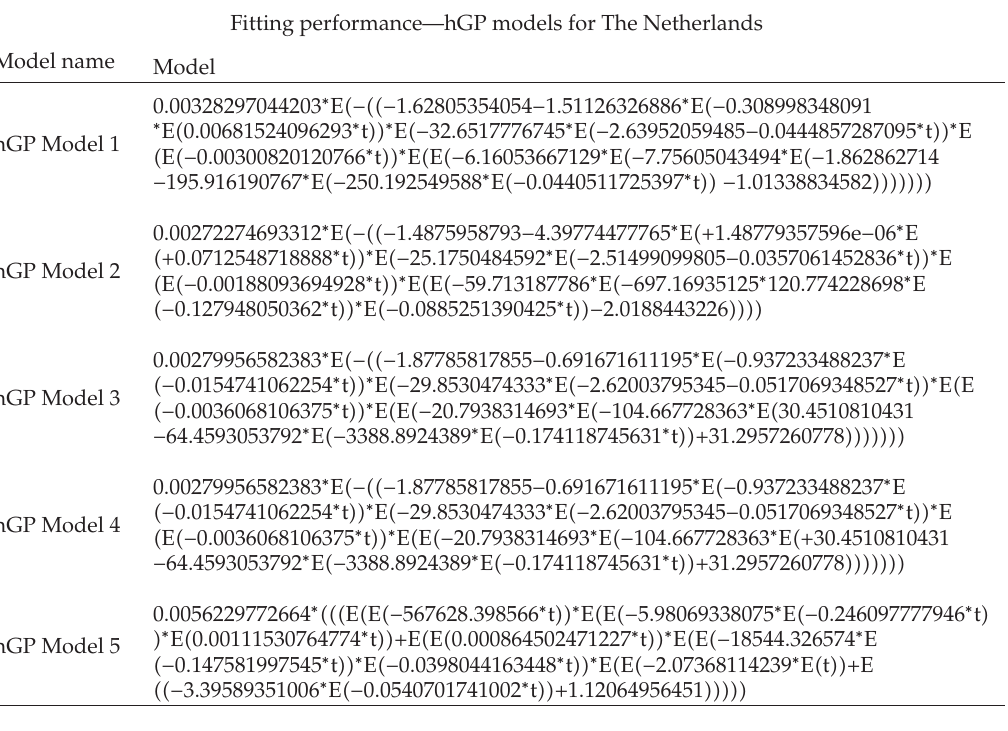
Table 25: Representation of the first five produced hGP models in fitting (cid:2) The Netherlands (cid:3) . Fitting performance—hGP models for The